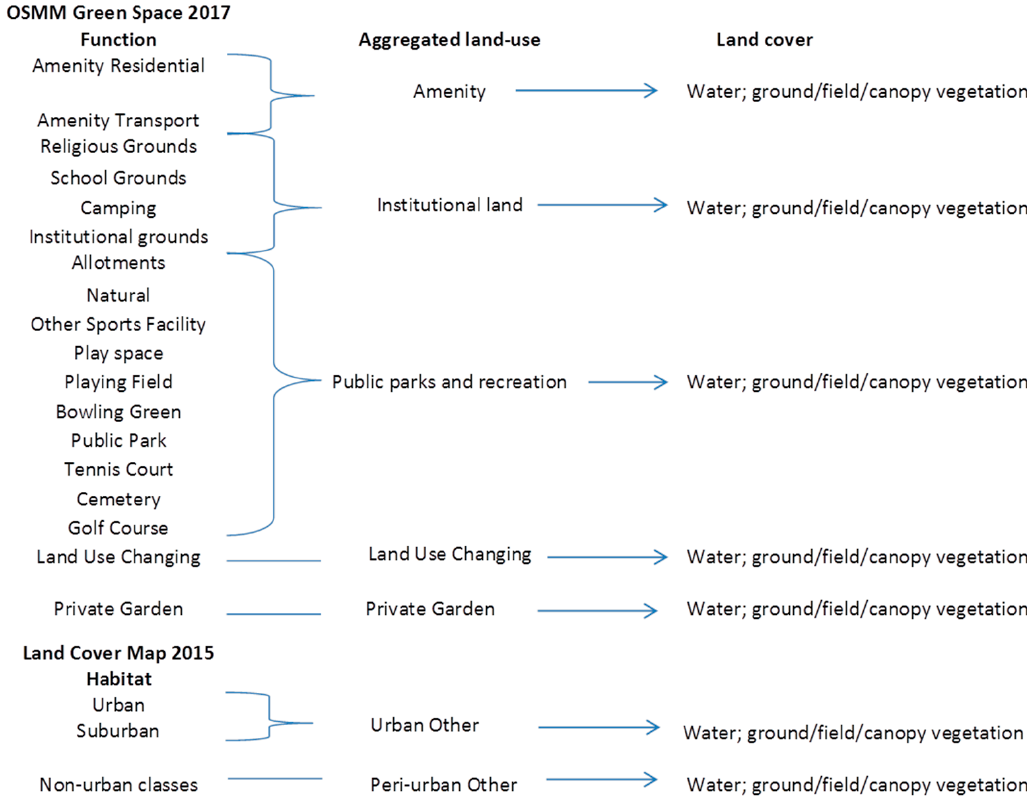
Figure 2. Decision tree of land use aggregation.